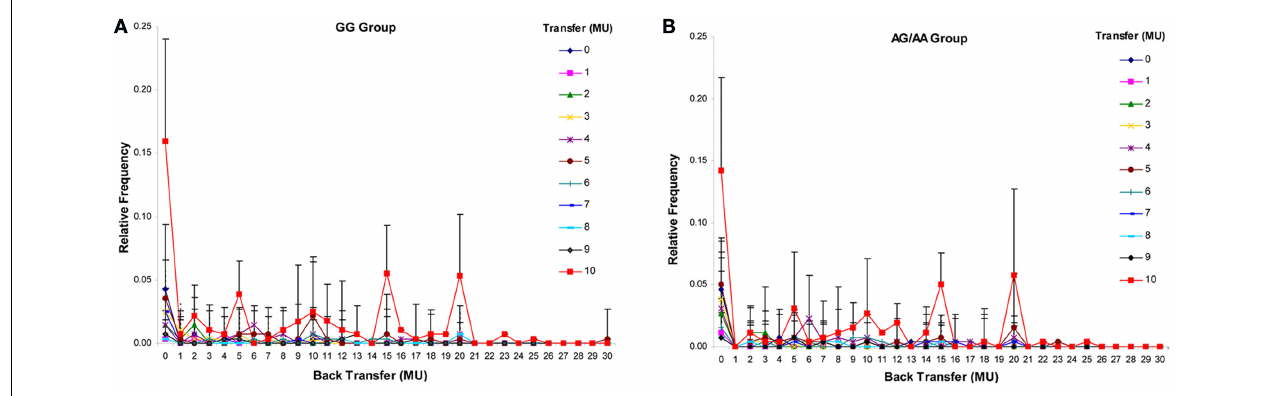
FIGURE 3 | Distribution of back transfers in the trust experiment. (A) Relative frequency of trustees’ back transfers in the GG group. (B) Relative frequency of trustee’s back transfers in the AG/AA group. MU, monetary